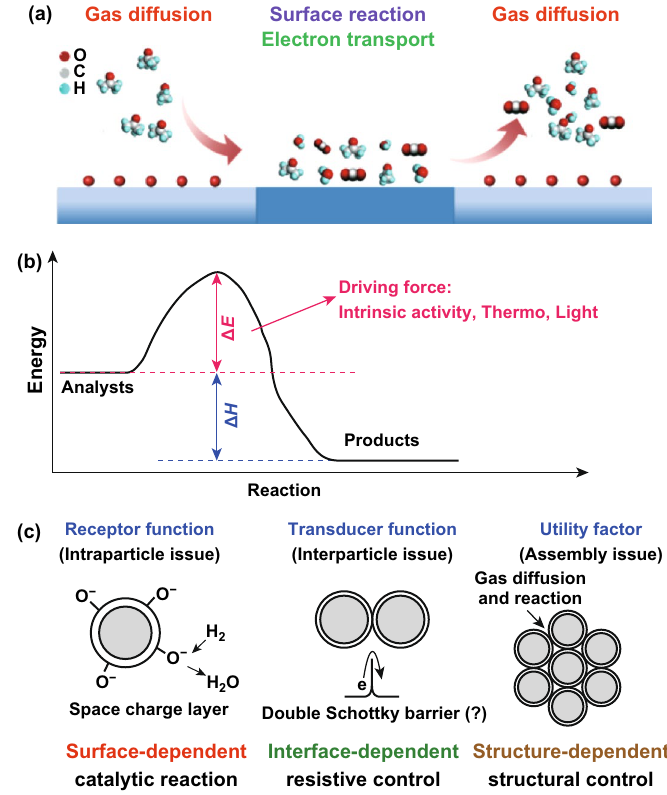
Fig. 1 Schematic illustration of a three gas-sensing units and b sensing reactions. c The enhanced gas-sensing mechanisms for hybrid chemi- resistive nanomaterials. The upper part of c was modified from reference. Reproduced with permission [38]. Copyright 2009,